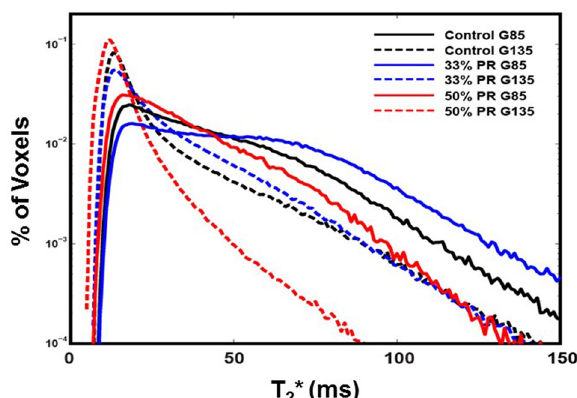
Figure 2. Histograms of placental T 2 * for PR vs. control animals at G85 (solid lines) and G135 (dashed lines). 50% PR animals (red) had a significantly smaller fraction of large T 2 * values at both G85 and G135 compared to controls (black) and 33% PR (blue), demonstrating decreased fetal oxygen supply in the former